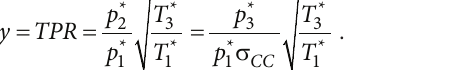
Figure 1. Major aerodynamic stations of the micro turbojet